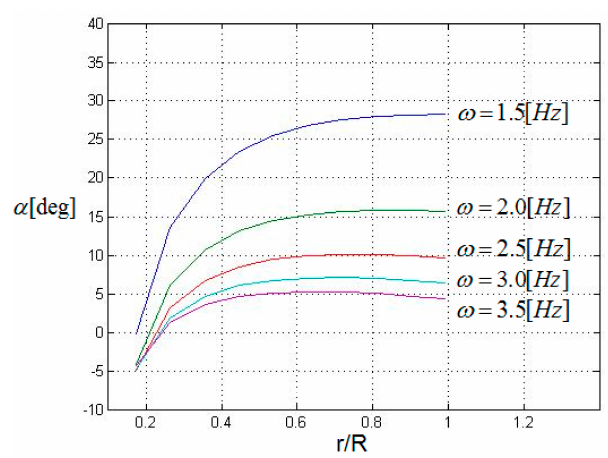
Figure 2. Drag at various frequencies.